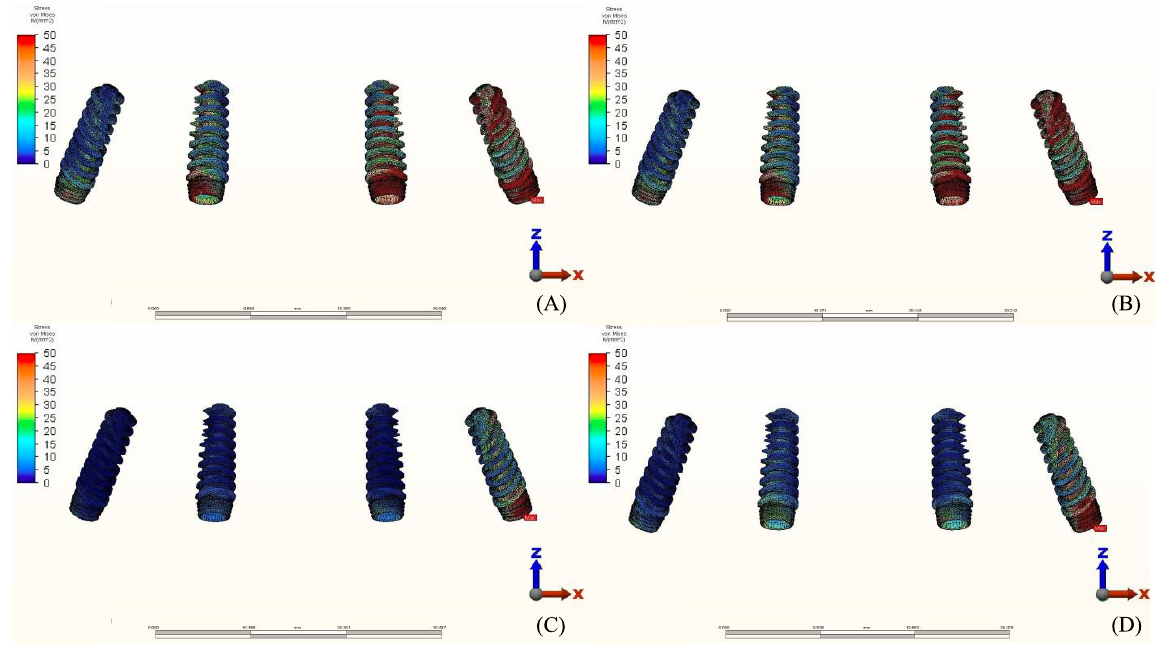
Figure 15. Implant stress distribution for group 3, PEEK bar with composite resin gingiva and ceramic superstructure with zirconium (Toronto bridge). ( A ) Model 3.1, opposing natural tooth. ( B ) Model 3.2, opposing tooth-supported full ceramic crown. ( C ) Model 3.3, opposing acrylic prosthesis with Ti framework. ( D ) Model 3.4, opposing implant-supported full ceramic crown.